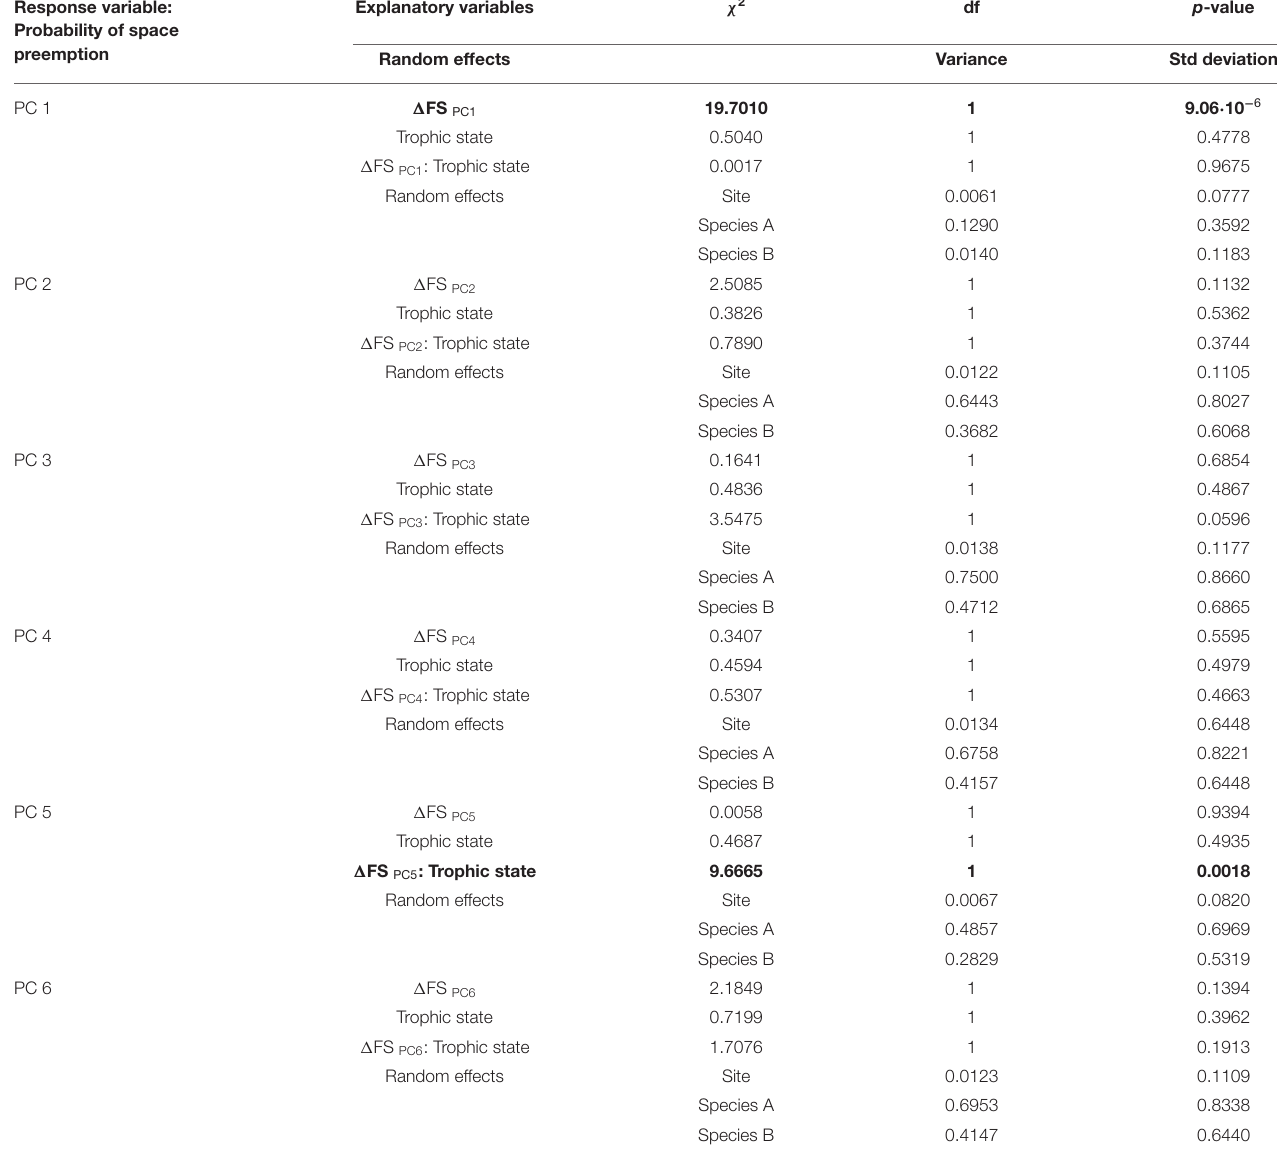
TABLE 6 | Complete output of generalized linear mixed-effects model testing the effect of the difference in the functional strategies ( 1 FS) of a seagrass pair on the probability of space preemption under different trophic states. Response variable: Probability of